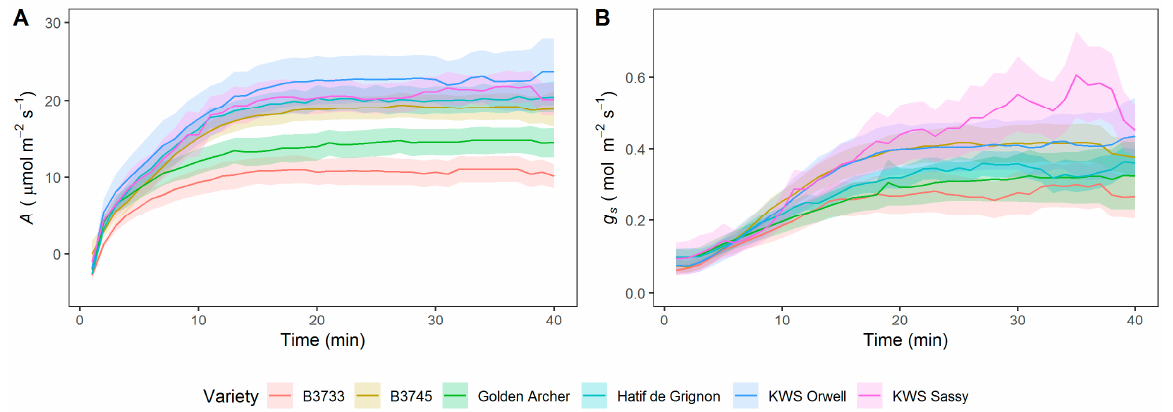
Figure 1. Step changes from low to high light intensity (0 to 1000 µ mol m − 2 s − 1 PPFD) for a selection of 6 polytunnel-grown barley varieties: 2 wild barleys (B3733 and B3745), 2 landraces (Golden Archer and Hatif de Grignon) and 2 elite cultivars (KWS Orwell and KWS Sassy), data shown start at t = 2 min after the initiation of high light intensity, to reduce noise. ( A ) Assimilation. ( B ) Stomatal conductance. Means shown +/ − se, N = 5–6 for each variety.